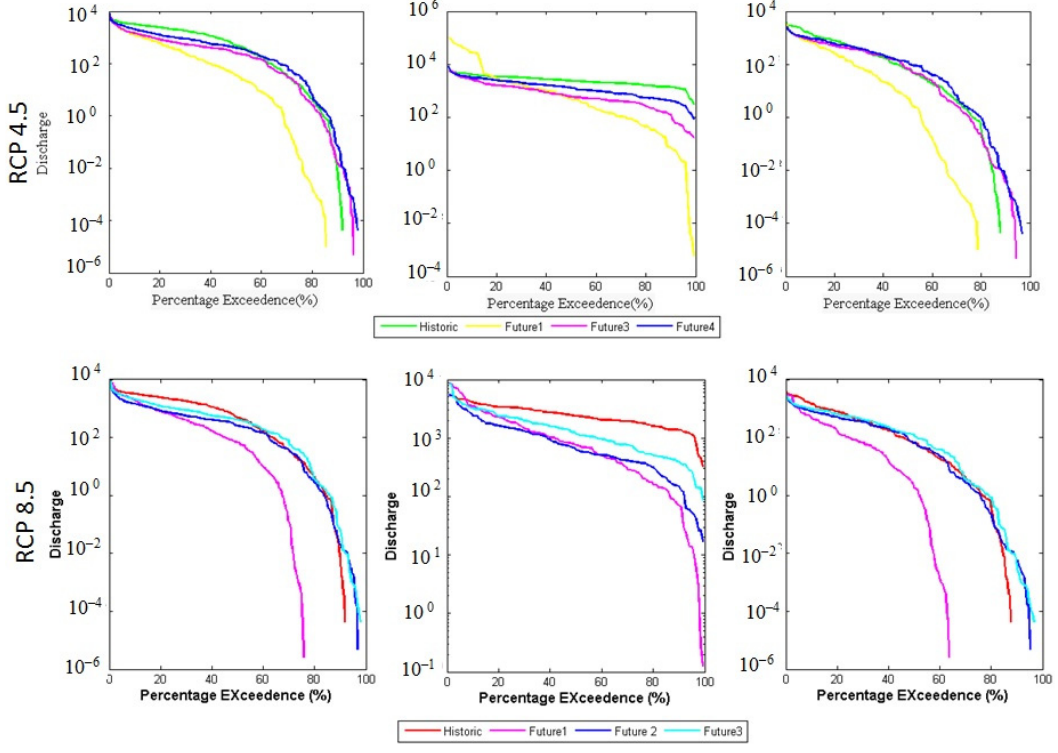
Figure 9. Annual, monsoon, and non-monsoon flow duration curves at the Mantralayam gauge station for historic and future periods under RCP 4.5 and RCP 8.5 scenarios.